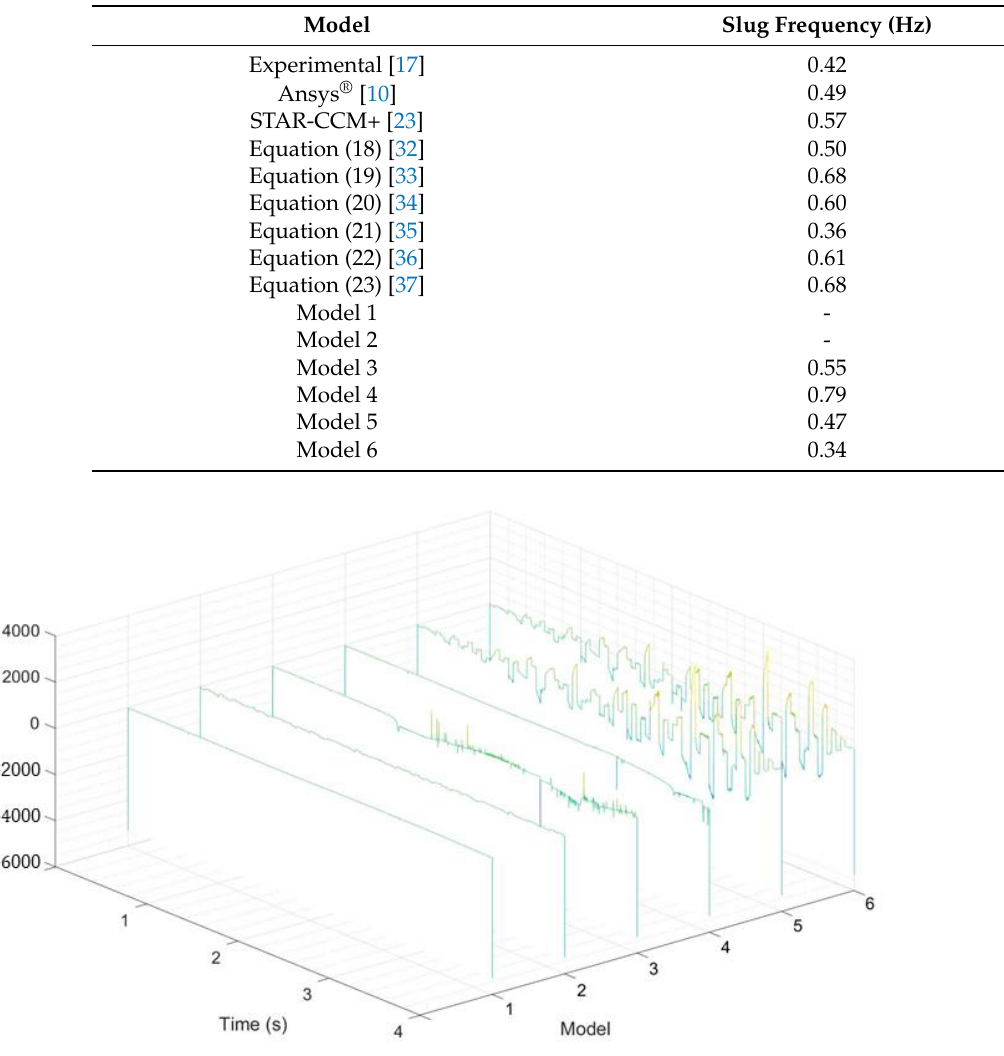
Figure 9. Compilation of pressure gradients for each model.